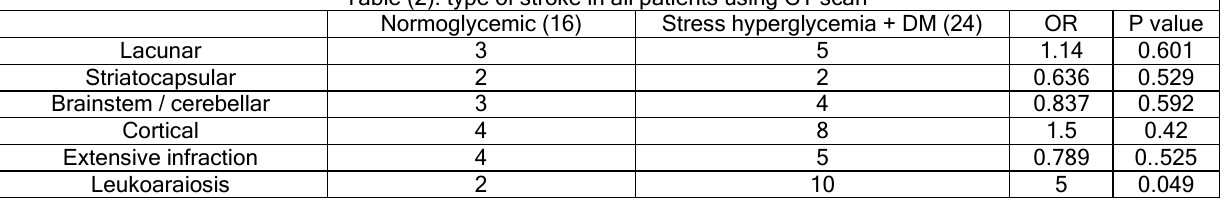
Table (2): type of stroke in all patients using CT scan